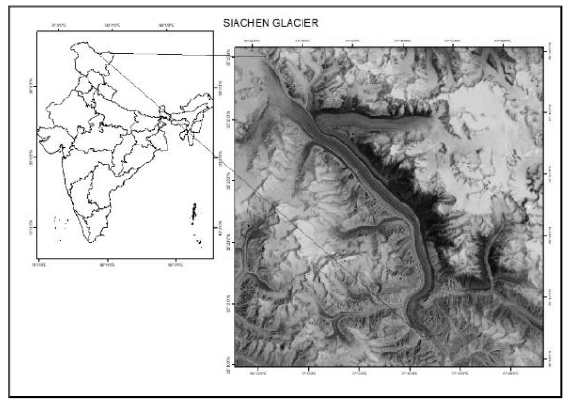
Figure 2: Siachen glacier location map.